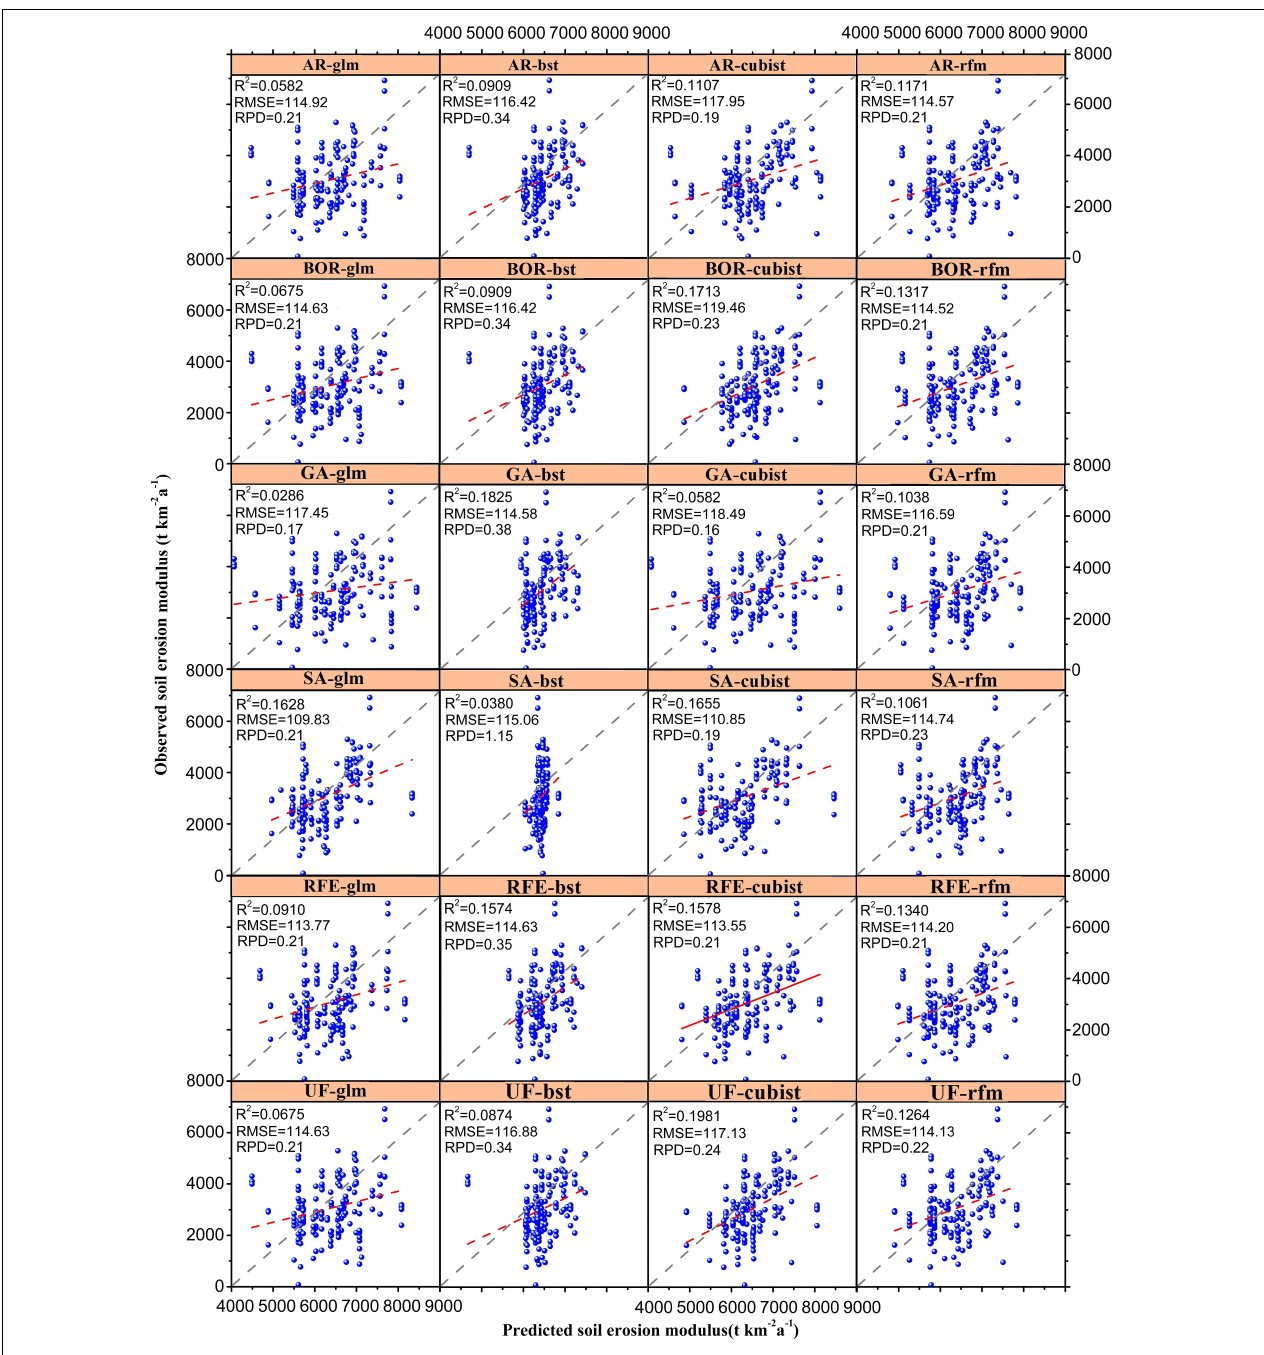
FIGURE 2 | Validation results of 24 models which combing six variable selection algorithms and four machine learning approaches. The six variable selection algorithms are: all relevant (AR), Boruta all-relevant (BOR), simulated annealing (SA), genetic algorithm (GA), recursive features elimination (RFE), and univariate filters (UF). The four machine learning approaches are: generalized linear model (glm), cubist model (cubist), random forest model (rfm), and boosting tree model (bst). Other abbreviations: R 2 , the coefficient of determination; RMSD, root mean squared deviation; RPD, residual prediction